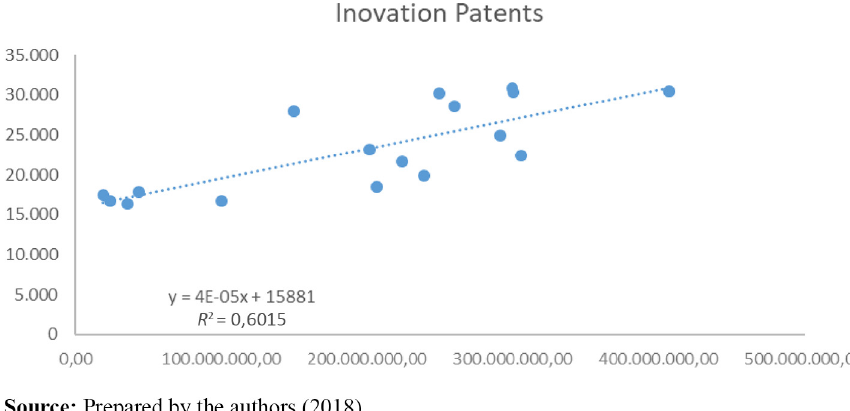
Figure 4. Regression